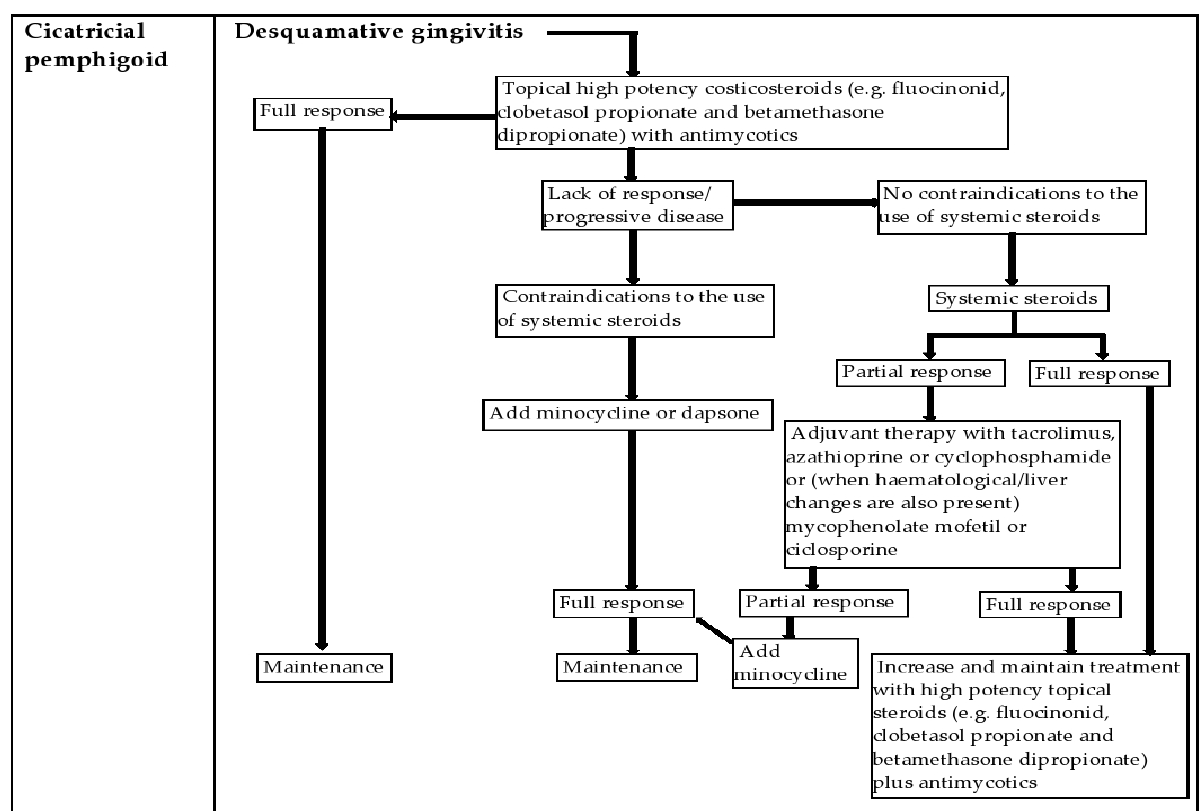
Figure 4. Treatment algorithm for desquamative gingivitis due to cicatricial pemphigoid. Palliative care may also be needed to alleviate the discomfort during mastication.